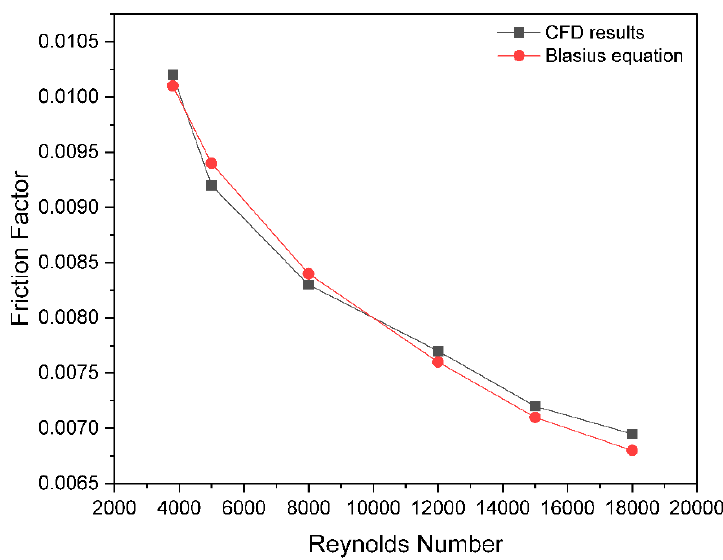
Figure 20. Validation of fr .